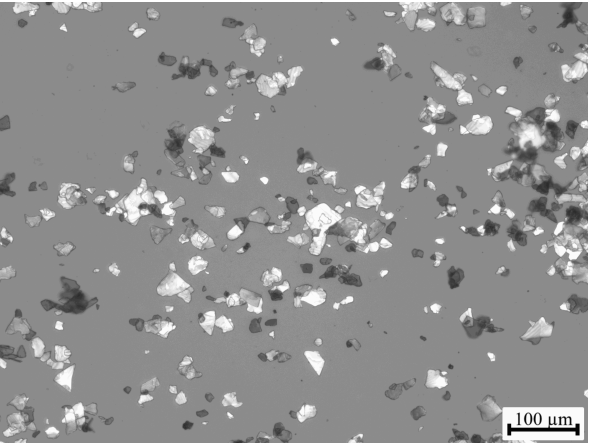
Figure 1. Microscopic image of mica powder in pale silver from Finnabair used in the experiments. To observe suspension behavior, L-alanine (99.7% purity, Evonik Industries AG, Nan- ning, China) in ultrapure water (18.2 M Ω cm) was selected as material system. The liquid phase is represented by saturated aqueous L-alanine solution at room temperature ϑ